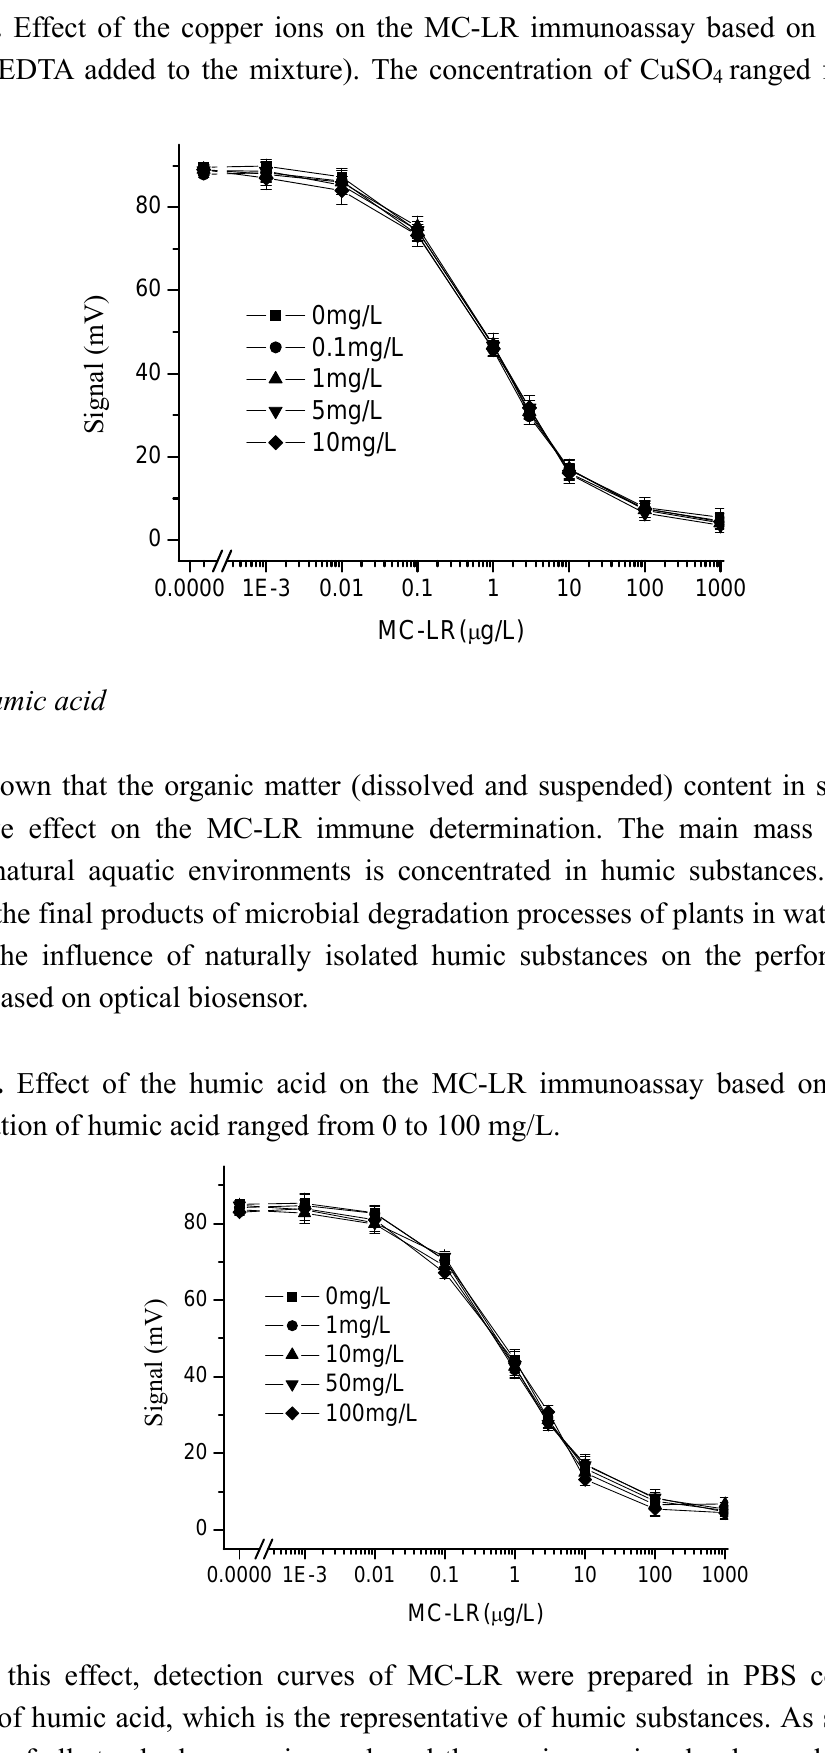
ranged from 0 to 10 4